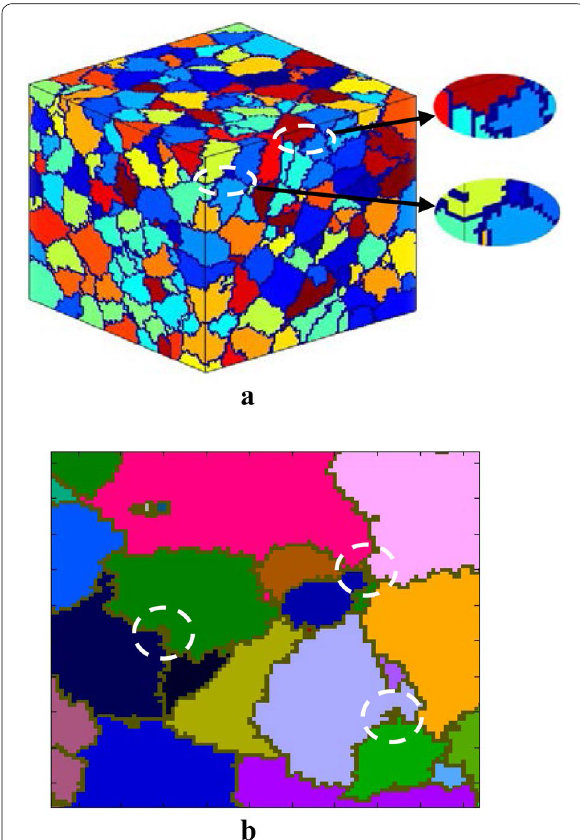
Figure 1 a 3D and b 2D simulated topological structures illustrating the grain overlap